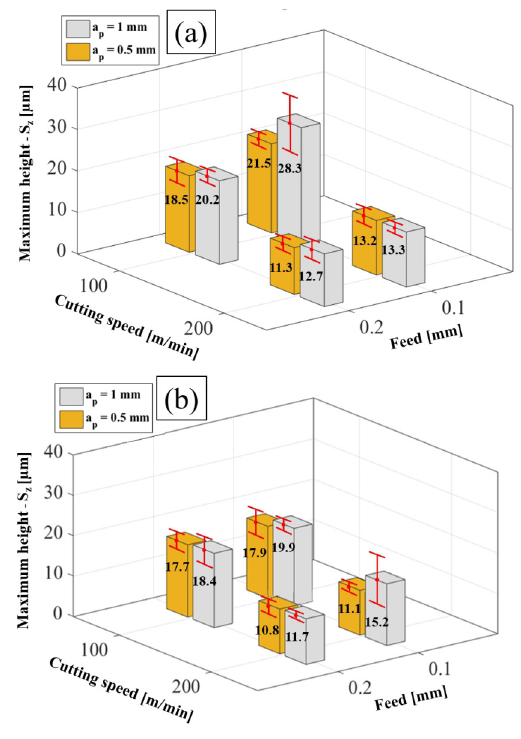
Figure 5. Average values with a confidence interval of the maximum height - S as a function of the cutting parameters for the machined z surface of (a) SP and (b) DP